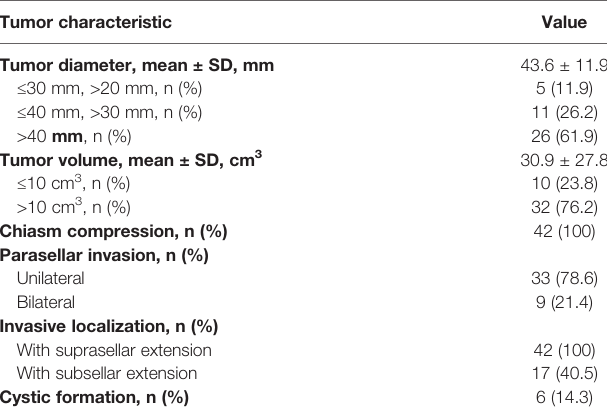
TABLE 2 | Imaging characteristics of large to giant pituitary adenomas in Knosp grade 4.